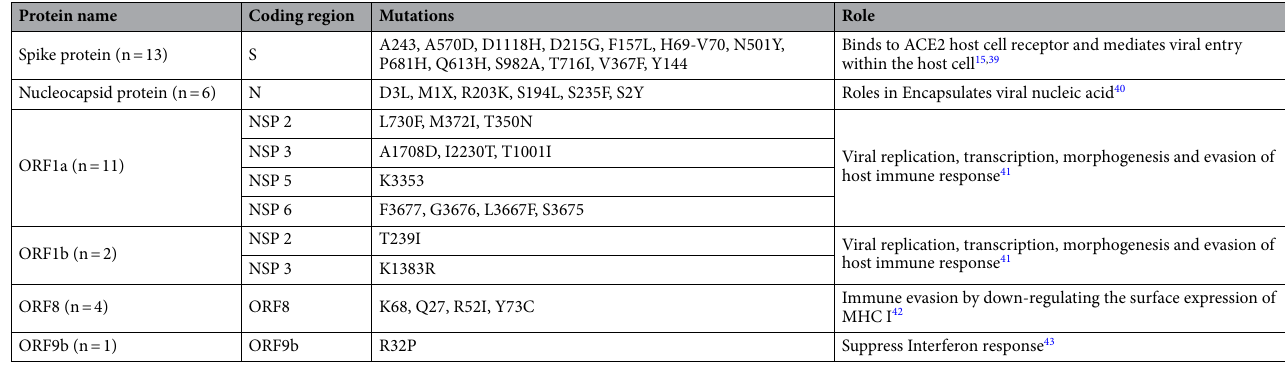
Table 3. Brief description of various structural and accessory proteins of SARS-CoV-2 that are significantly associated with hospitalized COVID-19 cases after adjustment for age and gender, and Bonferroni correction at p > 6.49 × 10 −4 .